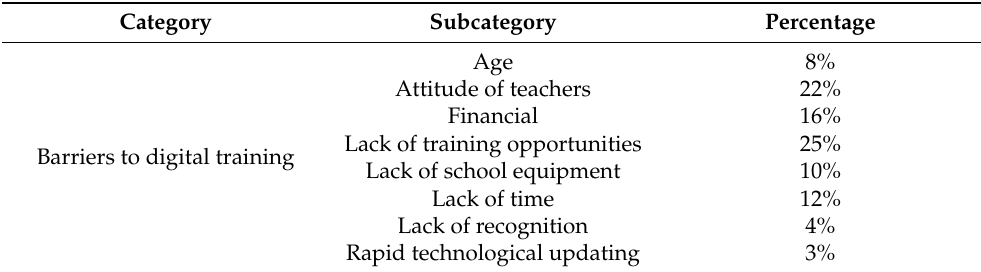
Table 5. Barriers to digital